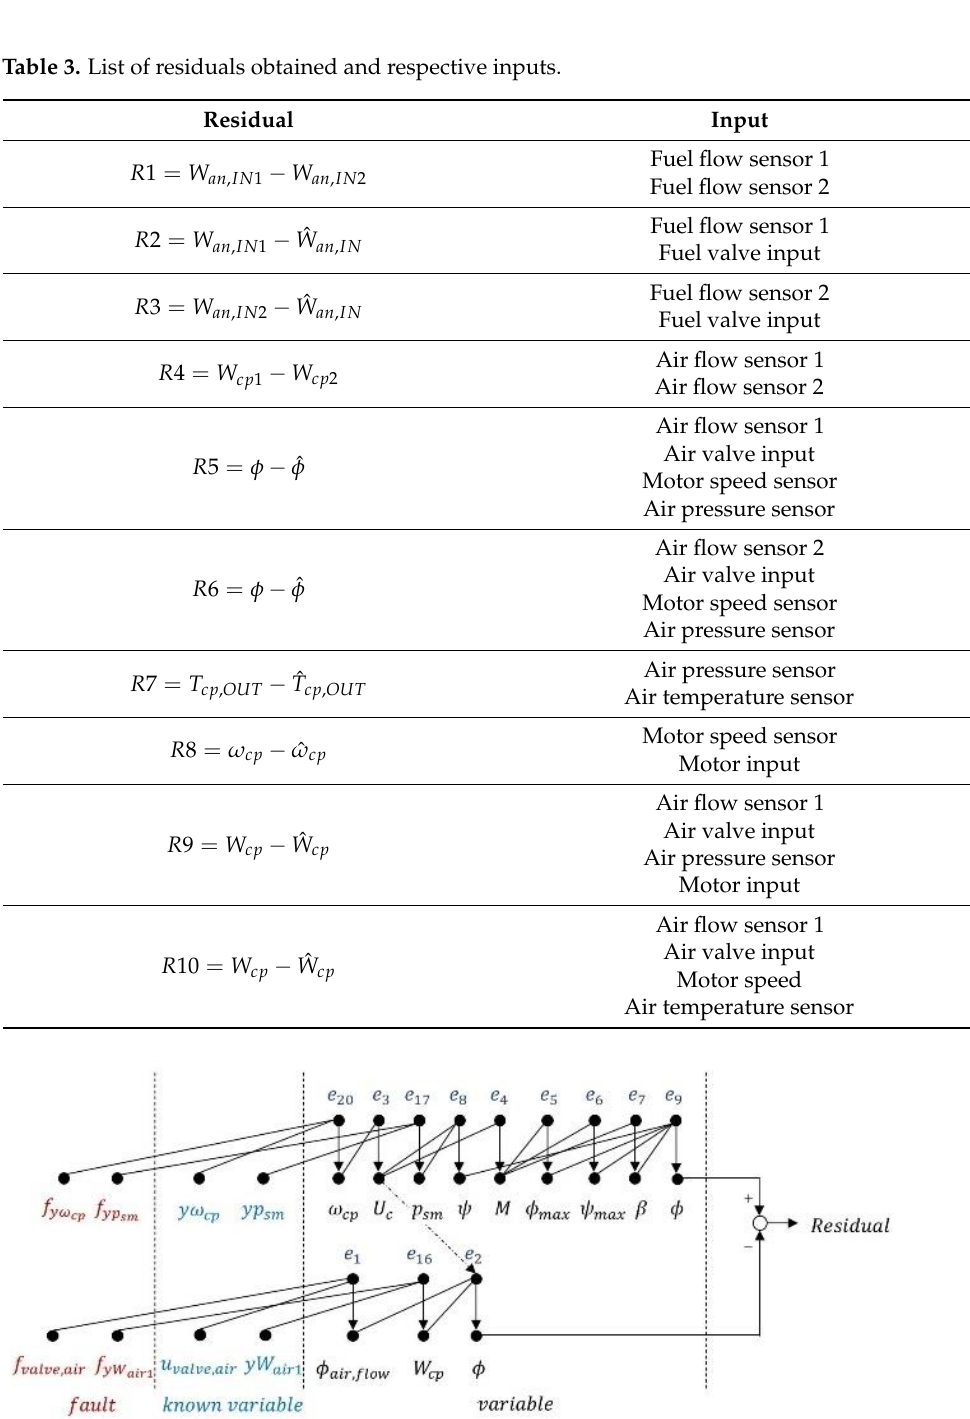
Table 3. List of residuals obtained and respective inputs.